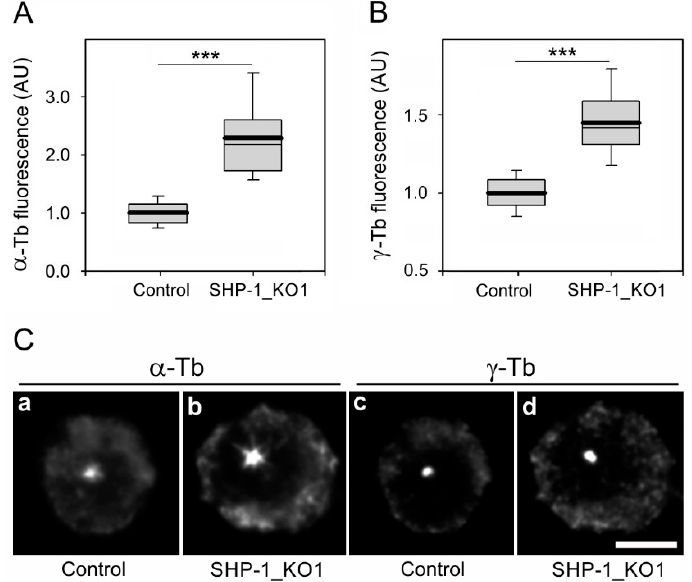
Figure 6. SHP-1 modifies microtubule regrowth. ( A , B ) The distribution of α -tubulin or γ -tubulin fluorescence intensities (arbitrary units (AU)) in 1- µ m ROI at 1.5 min of regrowth in BMMCs (Control) and SHP-1 deficient BMMCs (SHP-1_KO1) is shown as box plots (three independent experiments, > 30 cells counted for each experimental condition). ( A ) The box plot of α -tubulin fluorescence intensities in SHP-1_KO1 cells ( n = 100) relative to the control cells (Control, n = 100). ( B ) The box plot of γ -tubulin fluorescence intensities in SHP-1_KO1 cells (n = 100) relative to the control cells (Control, n = 100). The bold and thin lines within the box represent the mean and median (the 50th percentile), respectively. The bottom and top of the box represent the 25th and 75th percentiles. The whiskers below and above the box indicate the 10th and 90th percentiles. *** p < 0.00001. ( C ) The labeling of α -tubulin and γ -tubulin in the microtubule regrowth experiment in the control cells (Control; a , c ) and SHP-1_KO1 cells ( b , d ). The cells were fixed with F / Tx / M at 1.5 min of regrowth. The pairs of images Figure 6a,b and Figure 6c,d were collected and processed in exactly the same manner. Scale bar, 5 µ